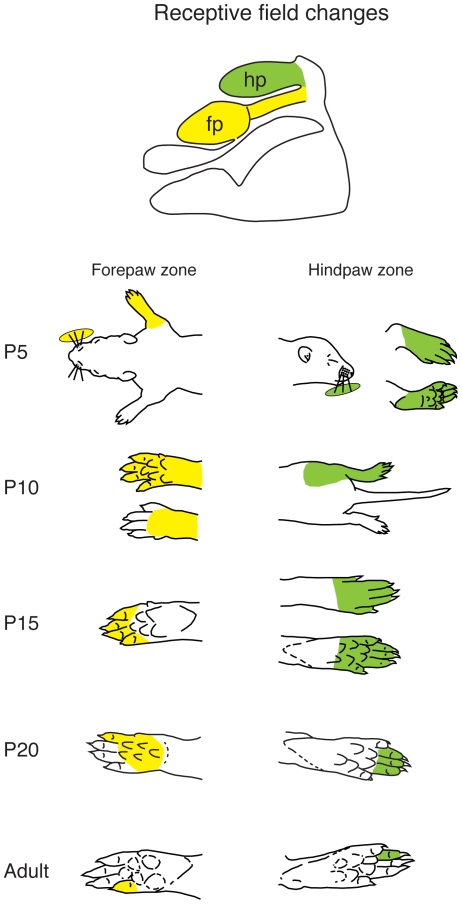
Changes in receptive field size and configuration at different developmental ages.The top illustration is a schematic of the body map in adults with the hindpaw zone marked in green and the forepaw zone marked in yellow. The receptive fields below for the different postnatal ages are for neurons in recording sites in each of these zones. At P5 there were very few recording sites with neurons that had receptive fields on either the forelimb or hindlimb. For those that did, receptive fields were large, and encompassed the vibrissae as well. With progressively older postnatal ages, the size of receptive fields for neurons in these zones decreased, and in adults, were small and often encompassed only a single digit or toe. Conventions as in previous figures.